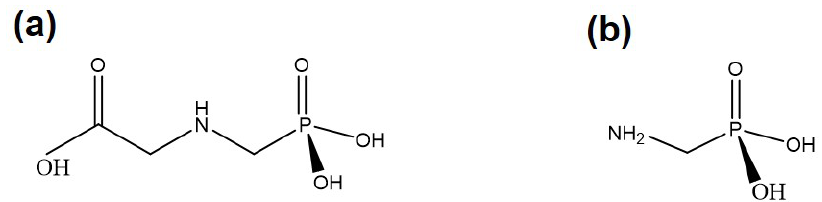
Figure 1. Chemical structure of ( a ) glyphosate (GLYP); ( b ) aminomethylphosphonic acid